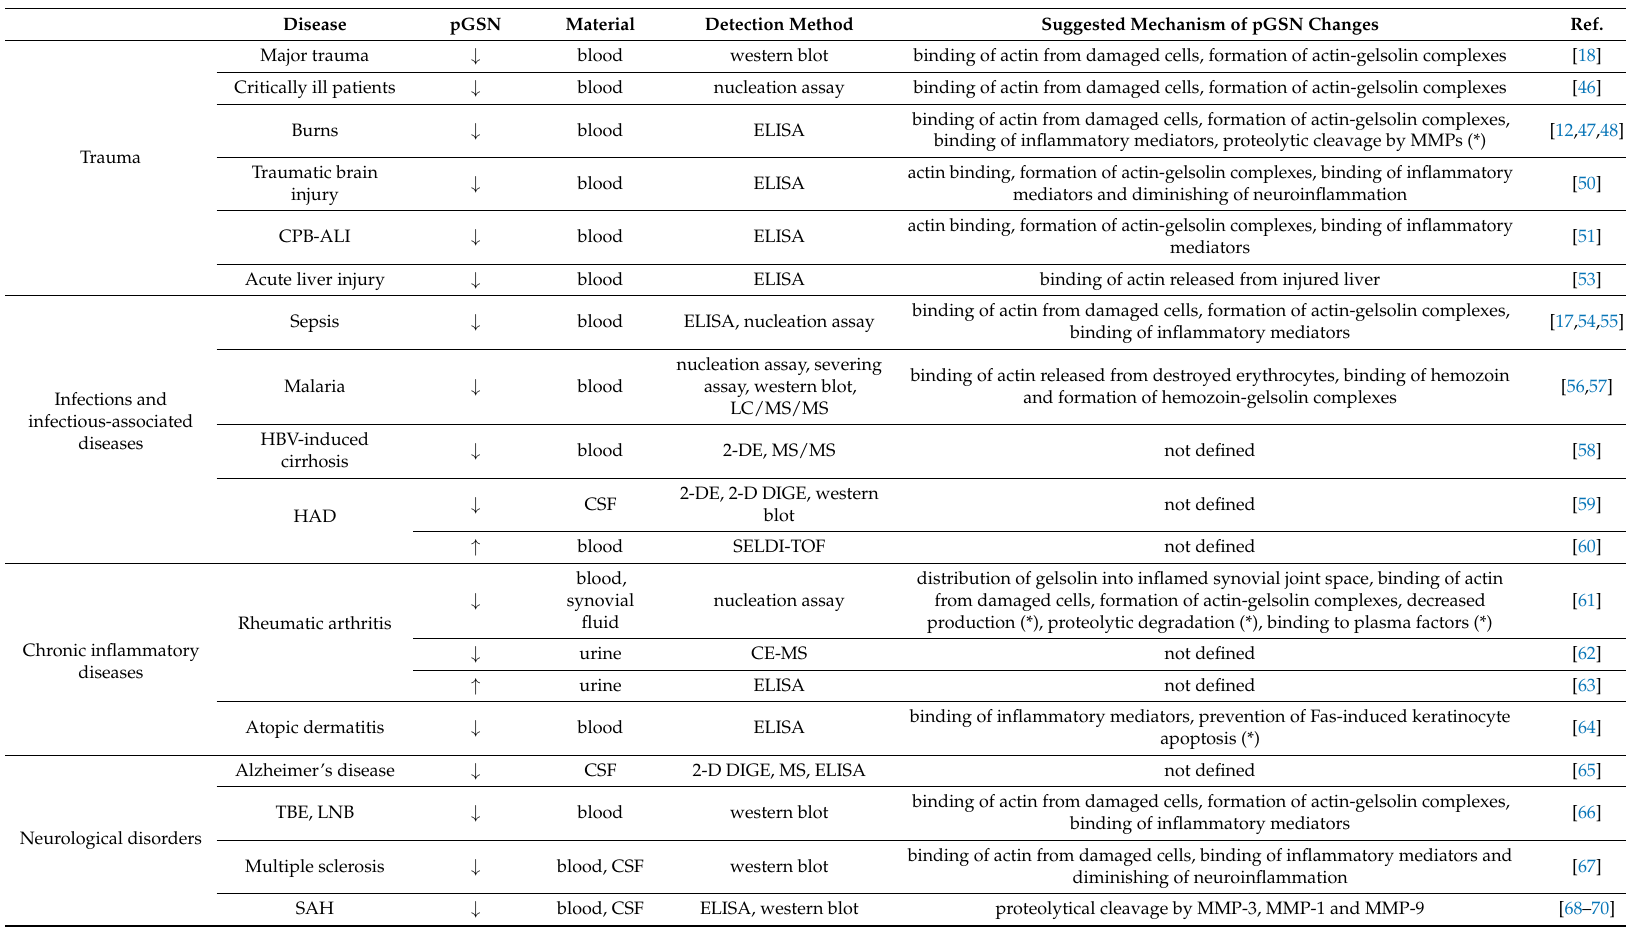
Table 1. Changes in plasma gelsolin concentration in selected diseases evaluated using human samples and suggested mechanisms of pGSN concentration